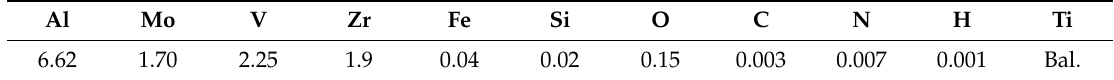
Table 1. Chemical composition of TA15 powders (wt %).